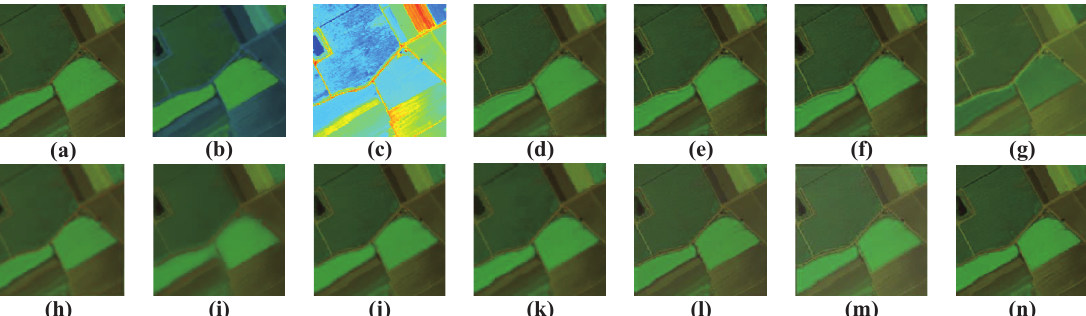
Figure 7. Visual results obtained by different methods on the Salinas Scene data set: ( a ) ground truth, ( b ) up-sampled HSI, ( c ) PAN, ( d ) SFIM, ( e ) MTF-GLP, ( f ) MTF-GLP-HPM, ( g ) GS, ( h ) GSA, ( i ) GFPCA, ( j ) CNMF, ( k ) Lanaras’s, ( l ) FUSE, ( m ) HySure, ( n ) SCAAE. Note that the false color image is chosen for